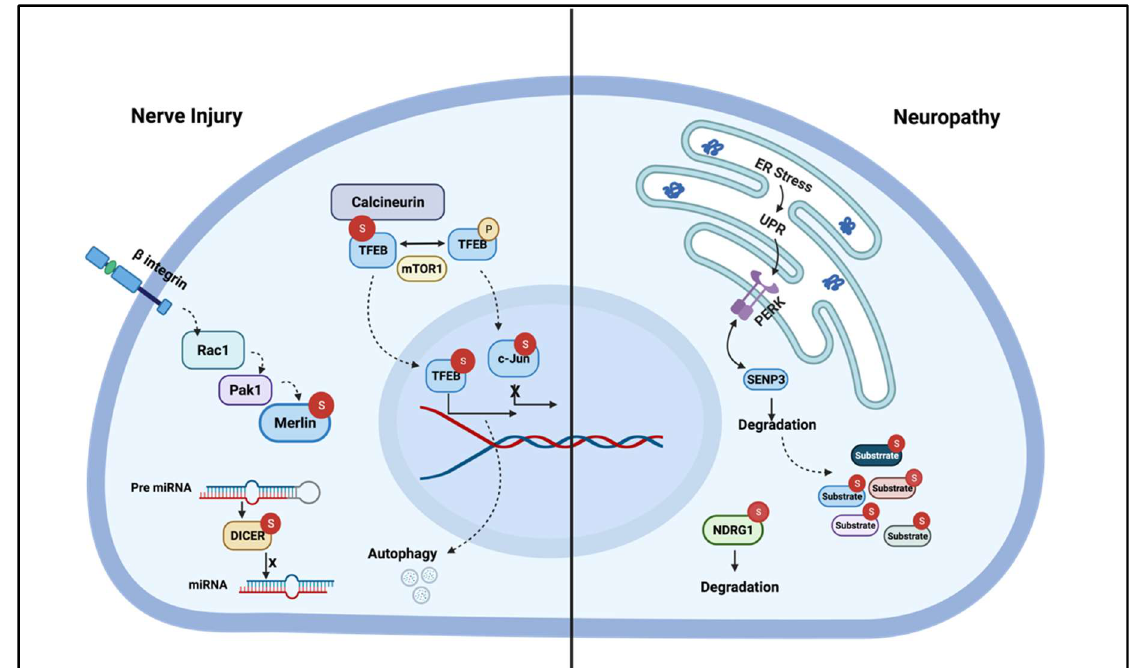
Figure 3. Putative SUMO substrate proteins in disease. ( Left ) SUMO-conjugated proteins are increased after peripheral nerve injury. Several proteins known to play roles in injury and regeneration have been reported to be SUMOylated in other contexts. For example, calcineurin promotes myelin autophagy via TFEB after injury, and the Calcineurin/NFAT signaling pathway becomes activated upon interaction with Sumo2 . TFEB may also be regulated by SUMOylation. In this way, the increase in SUMO-conjugation after injury may stimulate nerve repair. c-JUN, which is essential for the reprogramming of Schwann cells during nerve regeneration. When SUMOylated, c-JUN stability is disturbed and its transcriptional activity is downregulated, this PTM also affects its interaction with other complex proteins, a plausible mechanism to restore Schwann cell homeostasis. The endoribonuclease DICER is SUMOylated hampering its miRNAs processing activity, but DICER is needed for Schwann cell transdifferentiation in response to nerve injury. SUMOylation of Merlin (downstream the beta1 Integrin/Rac1 signaling pathway shown in Figure 2) affects its subcellular localization and subsequently inhibits cell proliferation and migration, which could possibly control Schwann cell response to injury. ( Right ) In neuropathies such as Charcot–Marie–Tooth (CMT) 1A and 1B, the Unfolded Protein Response (UPR) pathway is activated. One hypothesis is that the UPR could lead to accumulation of SUMO conjugated proteins in CMT1 as PERK tags the deSUMOylating enzyme SENP3 for degradation. Finally, N-myc downstream regulated gene 1 (NDRG1) becomes unstable when conjugated to Sumo2 , and mutations of this gene have been linked to CMT4D.